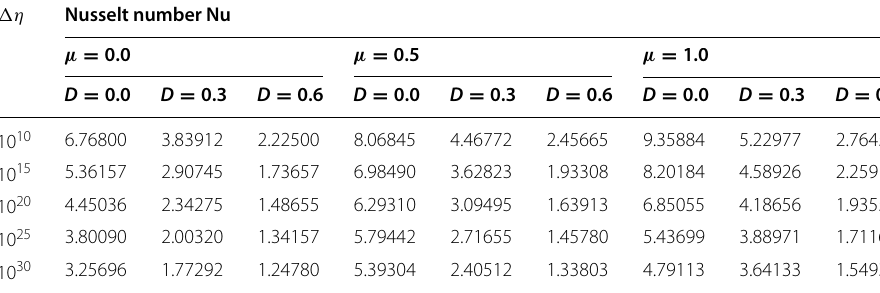
Table 4 Nusselt number Nu computed for µ = 0.0 , µ = 0.5 , µ = 1.0 with different viscous dissipation number D at Ra = 10 7 and θ 0 0.1 =